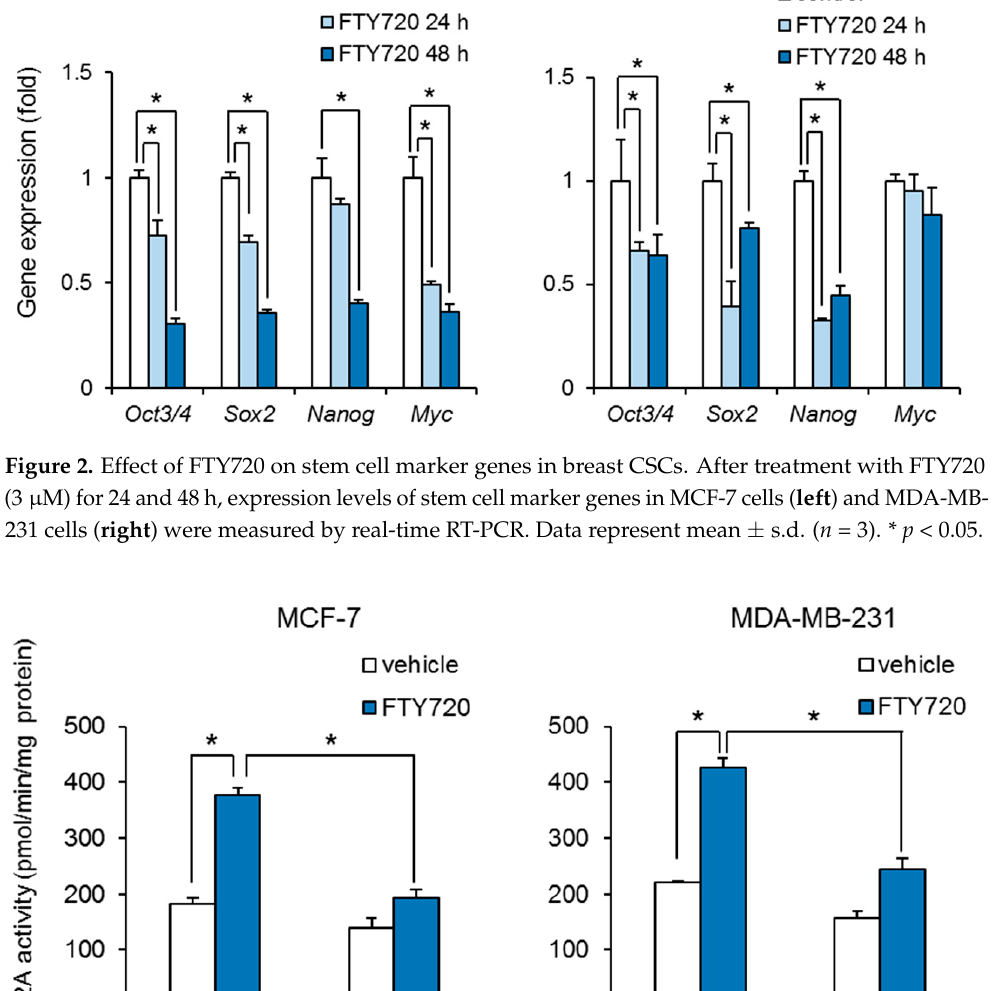
Figure 3. Effect of FTY720 on PP2A activity in breast cancer cell lines. After treatment with FTY720 (3 µ M) and/or PP2A inhibitor okadaic acid (OA, 30 nM) for 24 h, PP2A activities of MCF-7 cells ( left ) and MDA-MB-231 cells ( right ) were measured. Data represent mean ± s.d. ( n = 3). * p < 0.05.